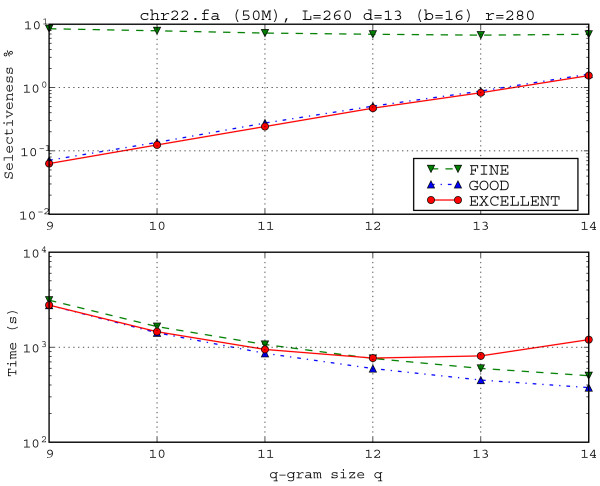
Influence of q-gram size q over selectiveness and running time. Influence of q-gram size q over selectiveness and running time for Human Chromosome 22 with parameters (L, d, r) = (260,13,280). Variant EXCELLENT gets slower and less selective if we increase q from q = 12 on.